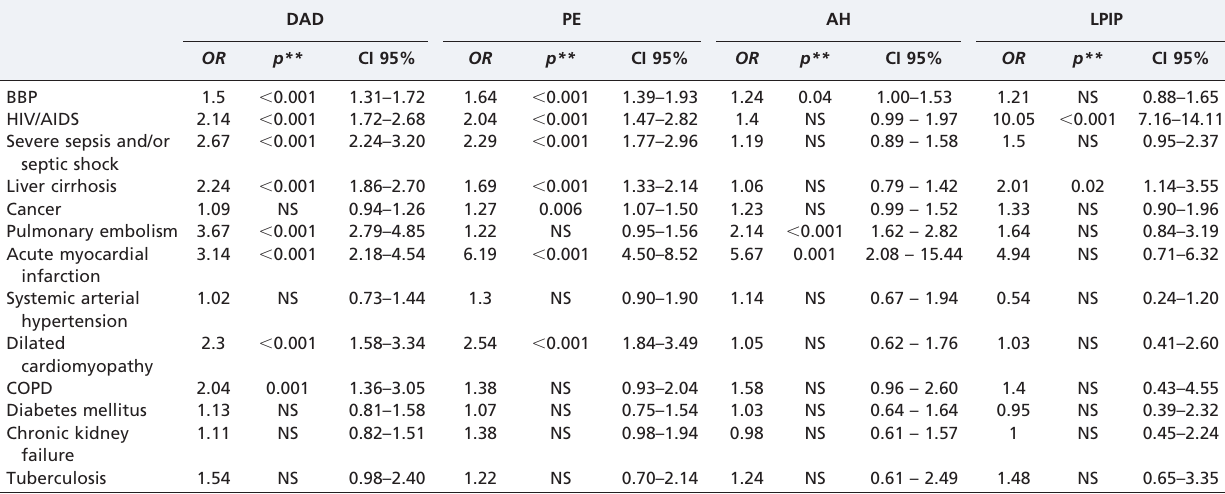
Table 3 - The multivariate analysis of the main associated diseases found in the autopsies of the patients with acute respiratory failure, showing the relationships with the respective pulmonary histopathological findings. DAD PE AH LPIP OR CI